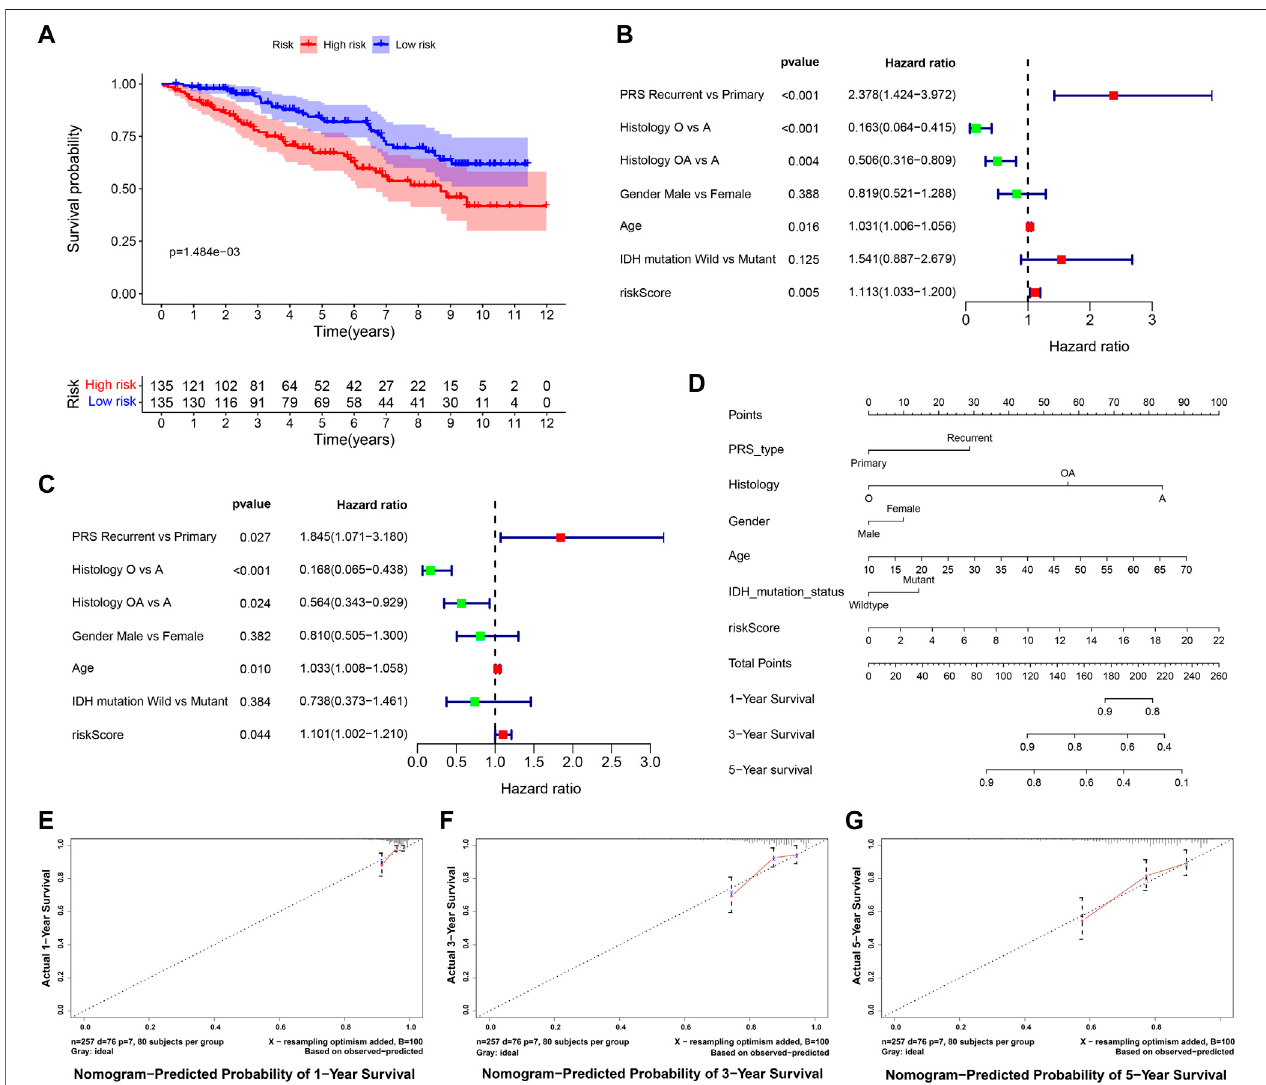
FIGURE 11 | Validation of risk score calculated by prognosis signi fi cant DE-ARGs (A) Kaplan – Meier analysis of patients from the high-risk group and low-risk group. (B,C) forestplotofunivariateandmultivariateCoxregressionforprognosisindicatorsincludingriskscore(histologytypes:A:Astrocytoma,O:Oligodendroglioma OA: Oligoastrocytoma). (D,G) nomogram with calibration curve in 1-year, 3-year, and 5-year.